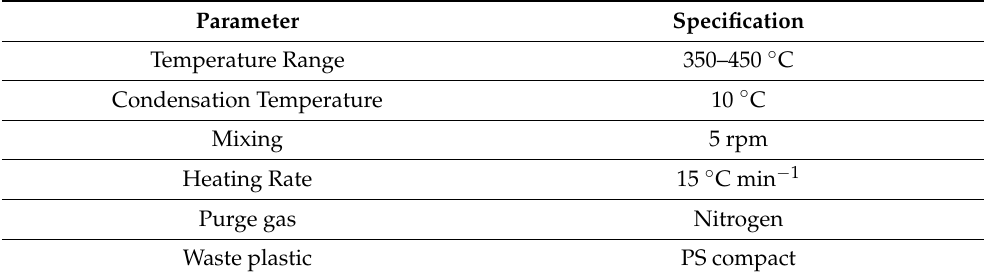
Table 2. Pyrolysis process